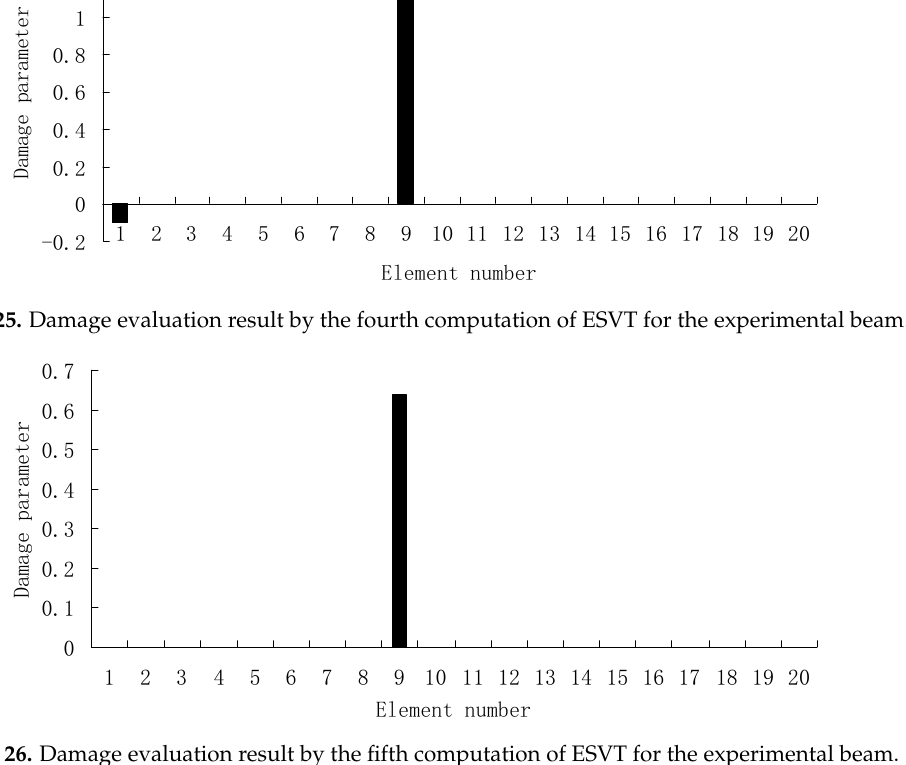
Figure 24. Damage evaluation result by the third computation of ESVT for the experimental beam.